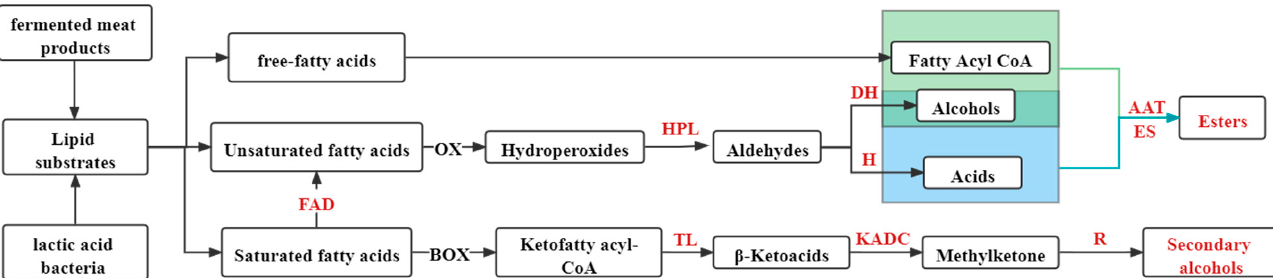
Figure 2. Metabolic pathways of lipids by lactic acid bacteria and the produced flavor substances.